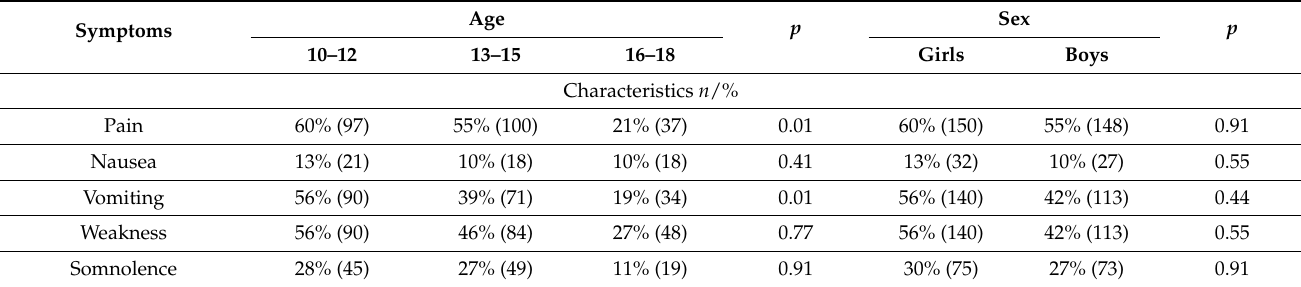
Table 4. Somatic symptoms among